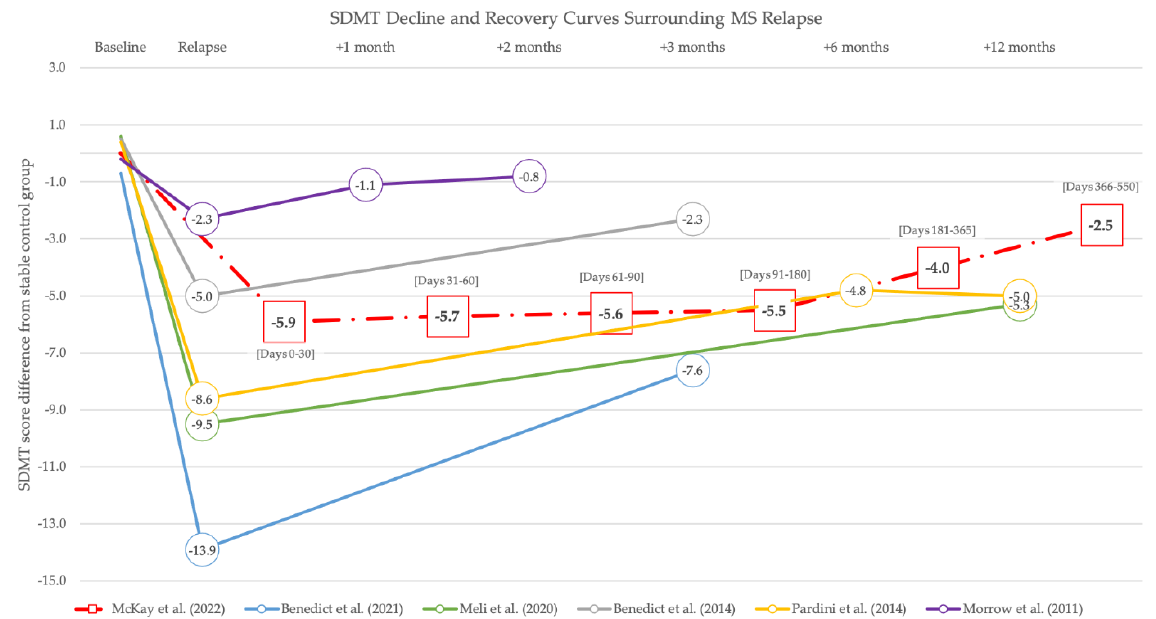
Figure 1. The SDMT decline and recovery curves surrounding MS relapse. The difference in raw SDMT scores between relapsing and stable MS patients across a variety of patient populations and timescales is shown. For each study, the mean score of the stable control group is subtracted from the mean score of the relapsing group. McKay et al. (bold text, red dashed line) represents the latest and most comprehensive study to date of cognitive change around MS relapse [35]. Because McKay used a national clinical database rather than a controlled study with discrete timepoints, each datapoint represents aggregate data from one of six distinct periods following relapse onset, indicated in brackets as the number of days post-relapse. Relapsing and stable groups were well matched at baseline across all studies with difference scores ranging from − 0.7 to 0.6. Included for reference are data from studies of cognitive relapse described elsewhere in this paper such as those led by Benedict [5,36], Meli [3], Pardini [6], and Morrow [33]. Cognitive recovery after relapse exhibits marked variation across studies but is generally considered